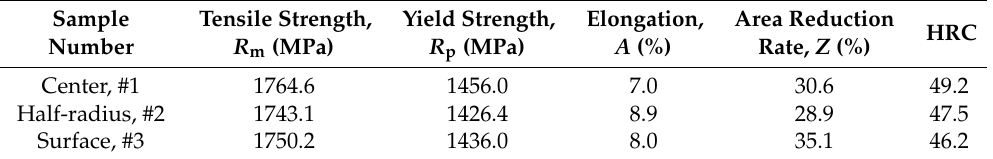
Table 4. Tensile property and hardness of different positions in H13 after